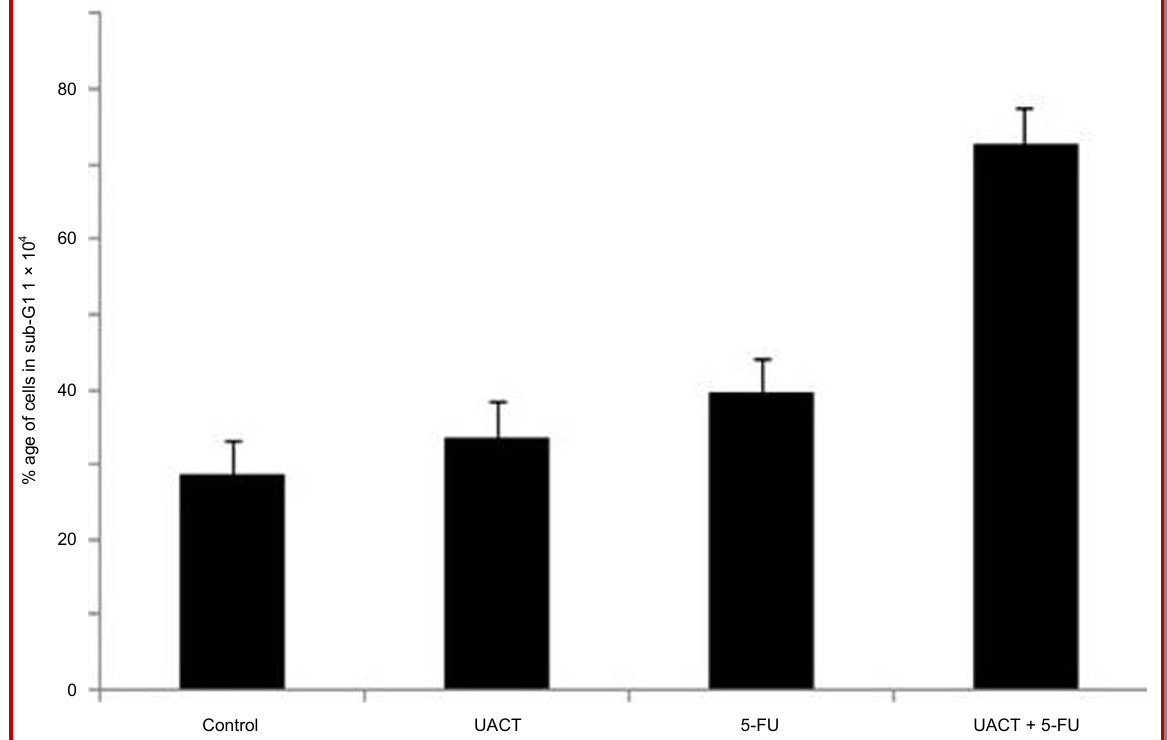
Figure 2: Flow cytometric analysis of the cytotoxic activities of UACT and 5-FU sequential combination in H209 cells. Control, untreated H209 cells for 72 hours; UACT, H209 cells treated with 50 µM of UACT for 24 hours followed by normal medium for an addition- al 48 hours; 5-FU, H209 cells treated with 20 μ M of 5-FU for 48 hours and UACT + 5-FU, H209 cells treated with sequential combination of UACT and 5-FU (100 nM and 10 nM respectively). Cells were fixed, stained and analyzed by flow cytometry as described in Materials and Methods. The Sub-G1 cell population is expressed as a percentage of total cell